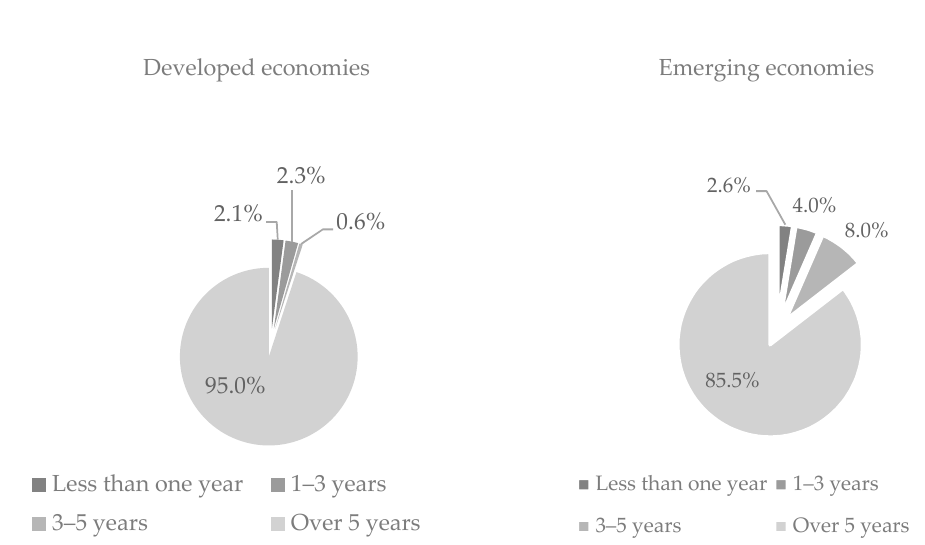
Figure 5. Experience in the use of social technologies.